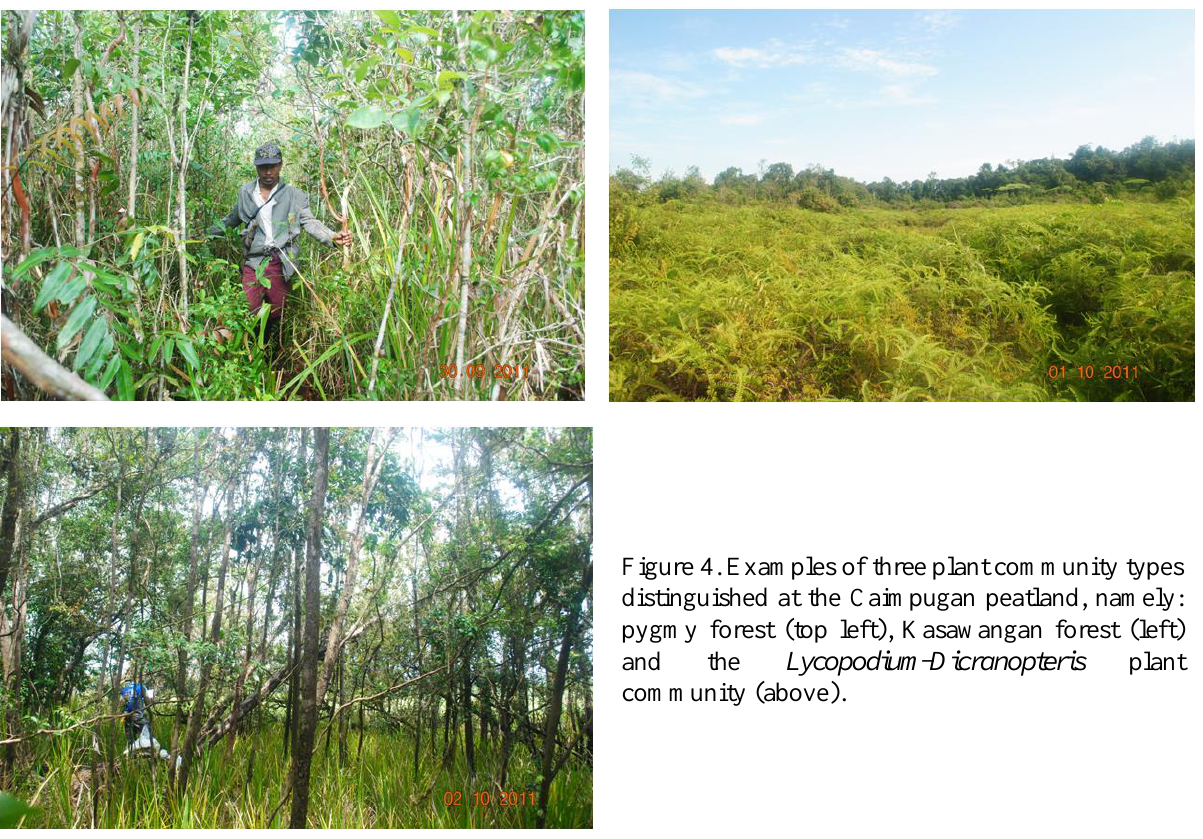
Figure 4. Examples of three plant community types pygmy forest (top left), Kasawangan forest (left) and community